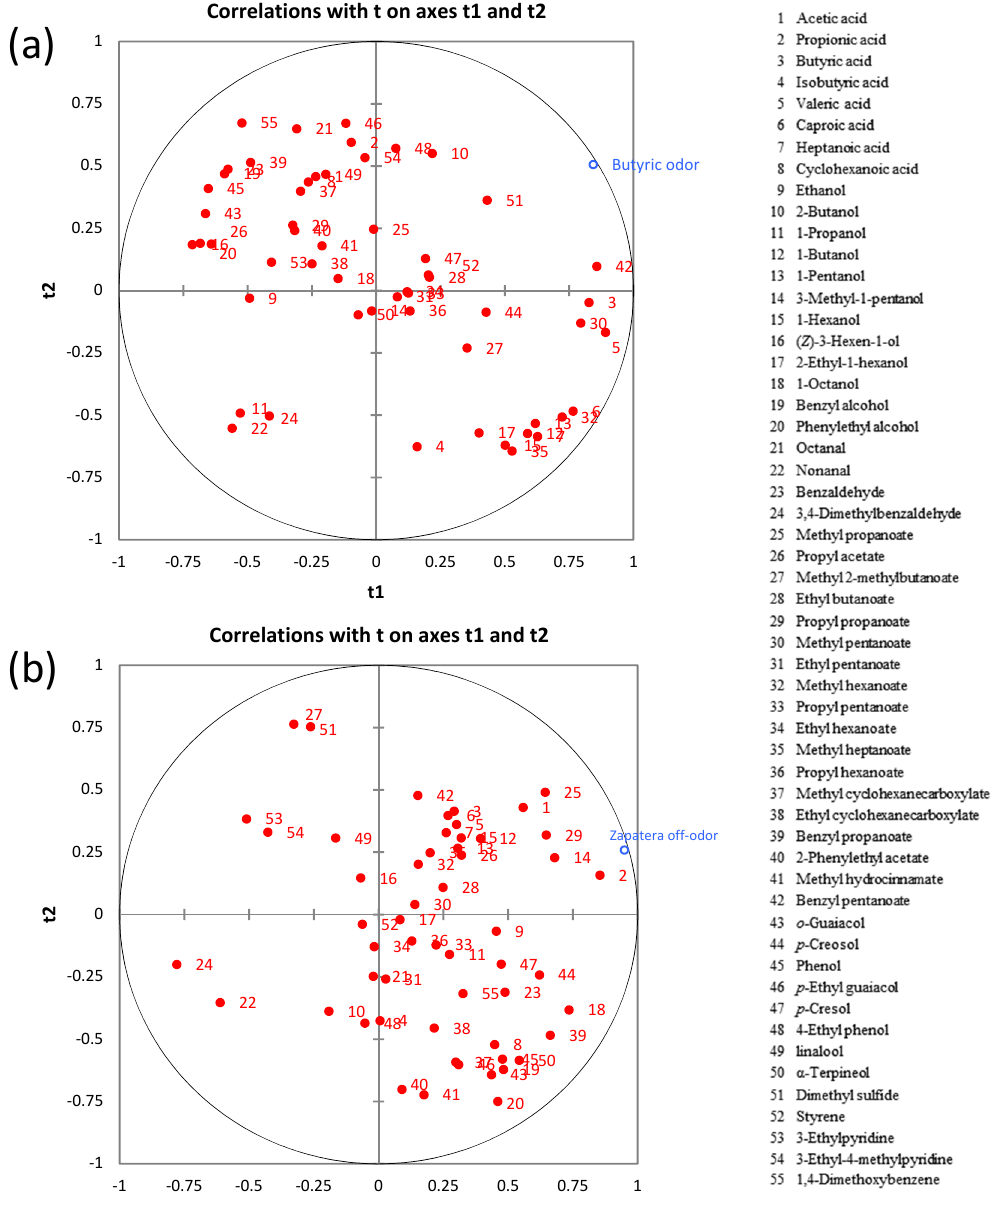
Figure 6. The PLS regression between the volatile metabolites and sensory spoilage descriptors: ( a ) butyric off-odor and ( b ) zapatera off-odor.